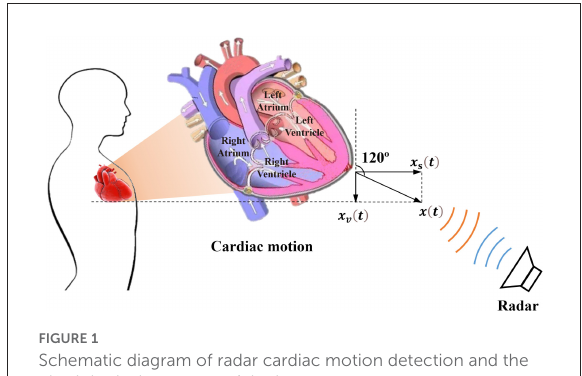
FIGURE1 Schematic diagram of radar cardiac motion detection and the physiological structure of the heart.